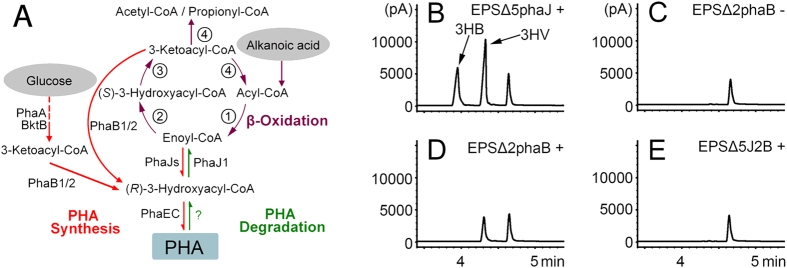
PHA biosynthesis in H. mediterranei from valeric acid.(A) Proposed PHA metabolism pathway in H. mediterranei from glucose49 and alkanoic acid. PhaA/BktB50, β-ketothiolases; PhaB1/227, acetoacetyl-CoA reductases; PhaEC21, PHA synthase; PhaJ, (R)-specific enoyl-CoA hydratase. The dashed line indicates involvement of multiple enzymes. The question mark (?) indicates that the enzyme that catalyzes the reaction is unknown. The predicted enzymes of ① acyl-CoA dehydrogenase, ② (S)-enoyl-CoA hydratase, ③ 3-hydroxyacyl-CoA dehydrogenase, and ④ 3-ketoacyl-CoA thiolase that were involved in β-oxidation pathway in H. mediterranei are listed in Supplementary Information Table S3. (B–E) GC analysis of the effect of PhaBs and PhaJs on PHA accumulation in H. mediterranei with or without valeric acid in the medium. Mutant strains were H. mediterranei EPSΔ5phaJ (B), EPSΔ2phaB (C,D), and EPSΔ5J2B (E). Different monomers (3-hydroxybutyrate, 3HB and 3-hydroxyvalerate, 3HV) are shown with arrows. The peak at 4.7 min represent methyl benzoate, which is used as an internal standard for quantitative calculation. ‘−’ and ‘+’ indicate without and with valeric acid added to the medium, respectively. pA indicates picoampere.